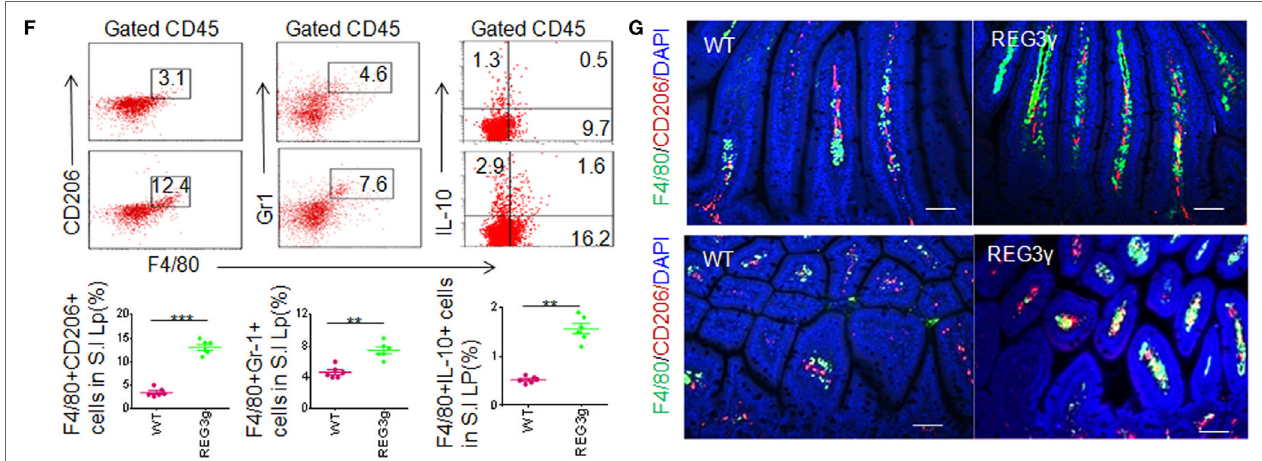
FigUre 1 | REG3 γ overexpression causes alterations of gut microbiota and expands the pools of anti-inflammatory macrophages. (a) 16S rRNA analyses of gut microbiota in huREG3 γ tgIEC and control littermate WT mice. The weaned huREG3 γ tgIEC (REG3 γ ) and control littermate WT mice were reared in different cages, and then 16S rRNAs from pooled small intestinal content samples ( n = 5, 7- to 8-week-old male mice fed normal chow) were amplified using primers that targeted the V3–V4 regions of the 16S rRNA. The samples were clustered at genus levels using the sample genus count matrices. WT, wild-type; REG3 γ , huREG3 γ tgIEC mice. See also NCBI with accession number SAMN04569211 and SAMN04569229. Data are a representative of three independent experiments. (B) Q-PCR of Lactobacillus genus in the ileum and proximal colon tissues of WT and huREG3 γ tgIEC mice fed normal chow ( n = 5). Standard curves were prepared from serial dilution of Escherichia coli genomic 16S rRNA. (c) Fluorescence in situ hybridization and immunostaining of ileum fragments in 7- to 8-week-old male huREG3 γ tgIEC mice (REG3 γ ) and control littermate WT mice. The representative images from five mice per group; Scale bars = 40 μ m. (D) Flow cytometry of MHCII( + )F4/80( + ), F4/80( + )CD11b( + ), and F4/80( + )CD11C( + ) macrophages in small intestinal (S.I) lamina propria of huREG3 γ tgIEC (REG3 γ /REG3g) and control littermate WT mice. The proportion of MHCII( + )F4/80( + ) macrophages in the S.I lamina propria of WT and huREG3 γ tgIEC mice were compared ( n = 6; lower). (e) Comparison of total MHCII( + )F4/80( + ) macrophages in the whole S.I lamina propria of huREG3 γ tgIEC (REG3g) and control littermate WT mice ( n = 6). (F) Flow cytometry of F4/80( + ) CD206( + ), F4/80( + )Gr-1( + ), and F4/80( + )IL-10( + ) macrophages in the S.I lamina propria of huREG3 γ tgIEC and control littermate WT mice. The proportion of MHCII( + ) F4/80( + ), F4/80( + )Gr-1( + ), and F4/80( + )IL-10( + ) macrophages in WT and huREG3 γ tgIEC (REG3g) mice were compared ( n = 6). (g) Immunostaining of F4/80( + ) CD206( + ) macrophages in the ileum tissues of huREG3 γ tgIEC (REG3 γ ) and control littermate WT mice. The representative images from six mice per group; scale bars = 40 μ m. * p < 0.05, ** p < 0.01, and *** p < 0.001 ( t -test, mean ± SD); NS, no significant. See also Figures S1–S3 in Supplementary